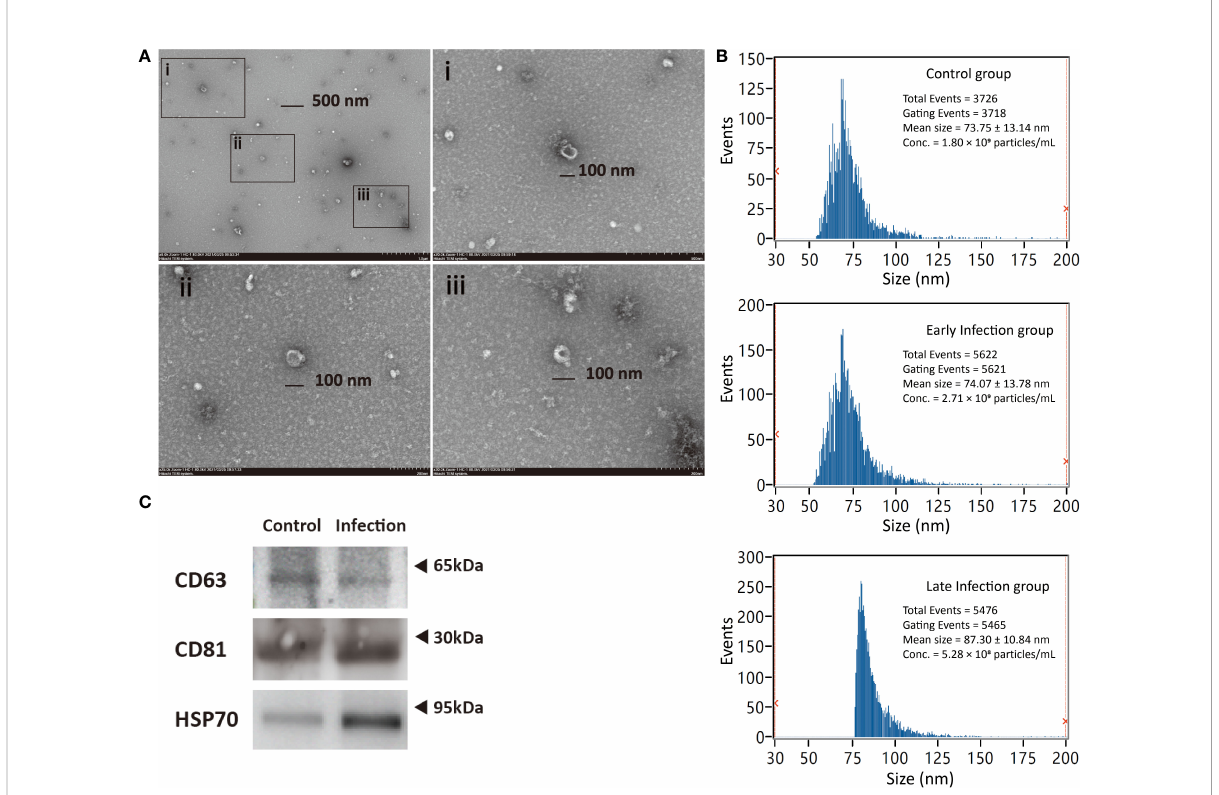
FIGURE 2 Characterization of exosomes from Cynoglosussus semilaevis plasma. (A) Exosomes morphology viewed by transmission electron microscopy with both wide- fi eld image (Top left) and close-up images (i-iii). i – iii denote the close-up images of exosomes with a diameter of ~100 nm at three different zones of the wild- fi eld image. (C) Particle size distribution and concentration in the control (C6 and C96), early- (IN6 and IN16), and late-infection (IN48, IN72, IN96) groups analyzed by Nano-FCM. (B) Western blotting examination of exosome biomarkers (CD63, CD81, and HSP70) in control (C6 and C96) and infection (IN6, IN16, IN48, IN72, and IN96)